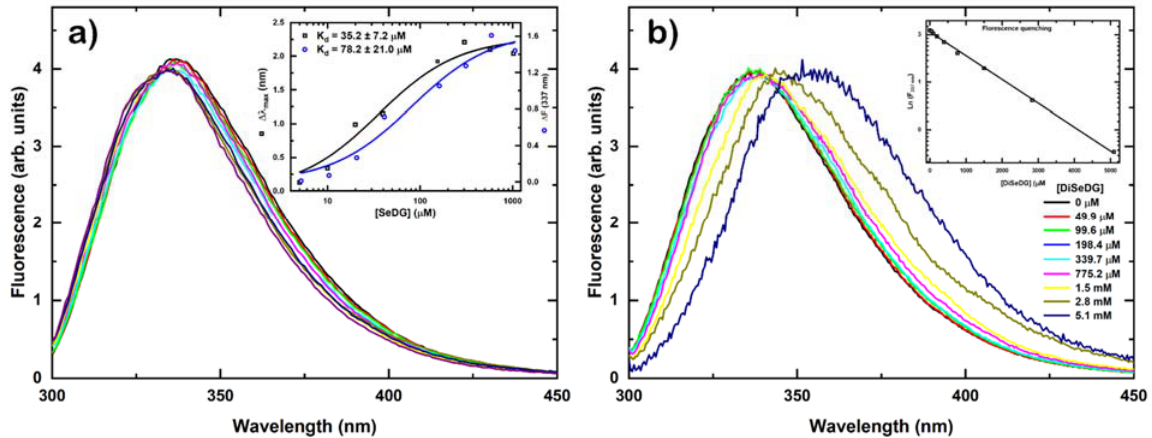
Figure 2. Fluorescence anisotropy measurements monitored by intrinsic Trp fluorescence at 25 °C. ( a ) Interaction of h Gal ‐ 3 with SeDG. The inset shows the binding isotherms for increasing concen ‐ trations of SeDG at 25 °C for the blue shift of the emission maximum wavelength (black squares) and for the fluorescence intensity at 337 nm (blue circles). Equilibrium K d values were derived by data fitting to a nonlinear regression model for single site ‐ specific binding using GraphPad Prism 8 and assuming one binding site per monomer. K d errors are estimates from the fitting algorithm. ( b ) Interaction of h Gal ‐ 3 with DSeDG. The inset shows the inner filter effect produced by the addition of the ligand to the protein solution.